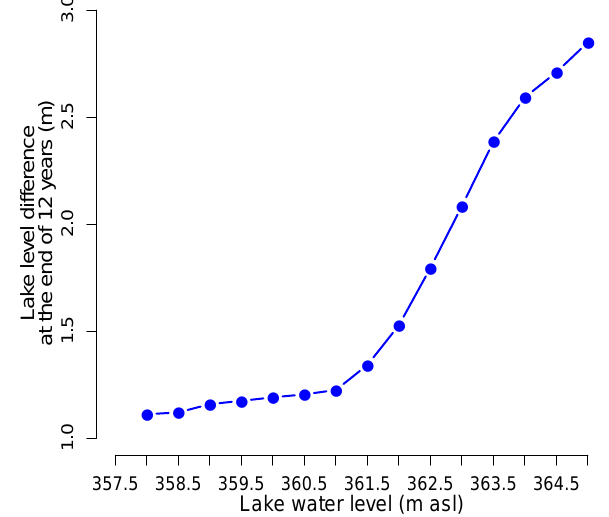
Fig. 7. Impact of the Gibe III dam (difference between with and without dam) at the end of 12yr simulation period is a function of initial lake level at the time of commencement of the